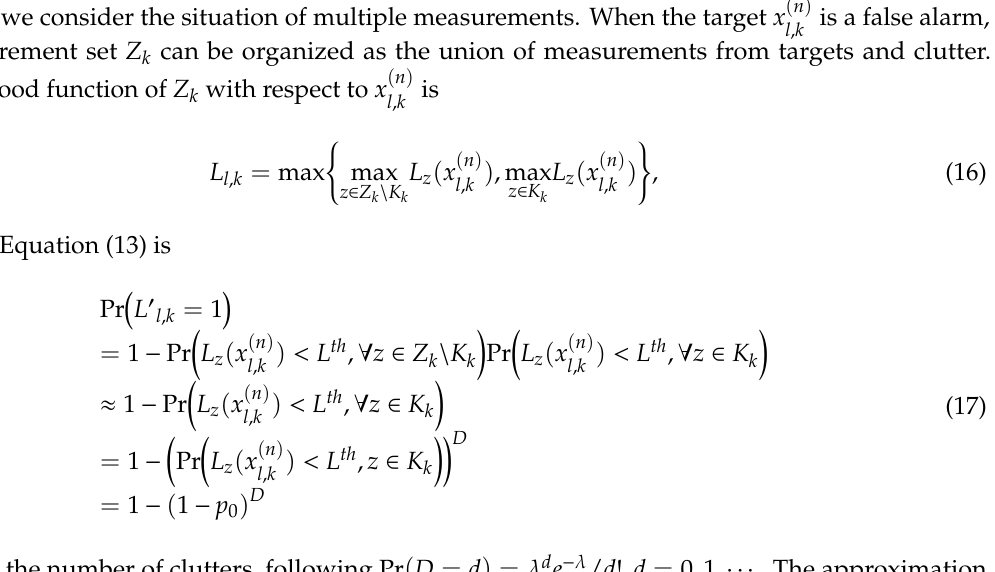
Figure 1. Probability that the likelihood function of target measurement is above the threshold.